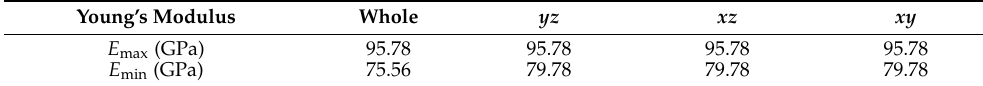
( a ) ( b ) Figure 5. Two-dimensional projections in yz , xz and xy planes of (a) maximum shear modulus and ( b ) minimum shear modulus of Ag 9 In 4 . Table 6. Maximum and minimum values for the shear moduli of Ag 9 In 4 . Shear modulus